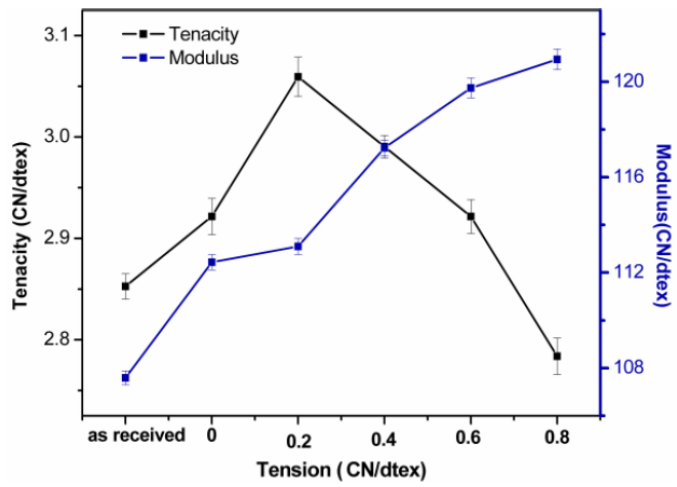
Figure 5. Tenacity and modulus of fibers under various tensions.